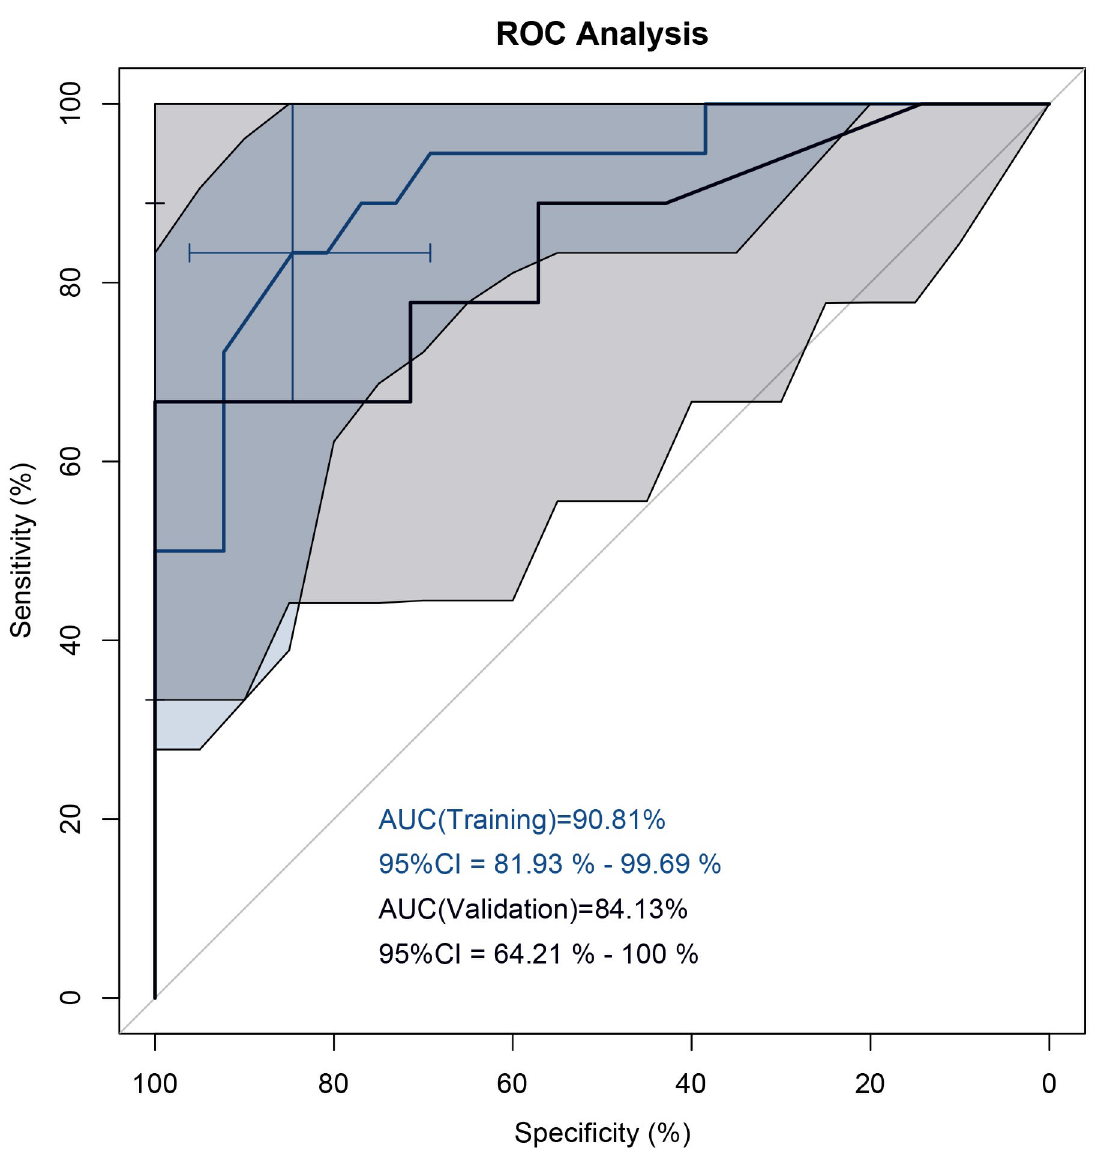
Fig 1. ROC analysis best fit antibody panel: Training (blue line) vs validation (black line) cohort. shaded areas represent the 95% confidence interval.